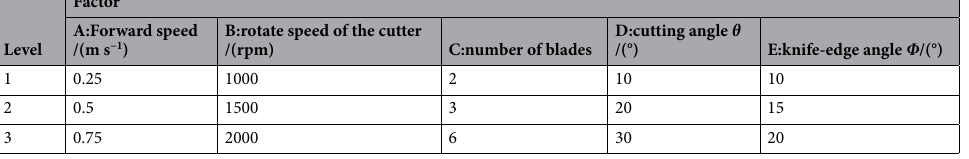
Table 2. Experiment factor level.